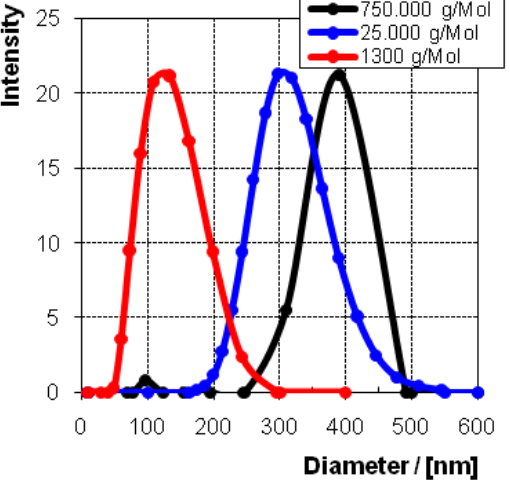
Figure 11. Intensity distributions of PEC-0.6 dispersions of PEI/APC at c and pH = 7/7 for three different PEI molecular weights.